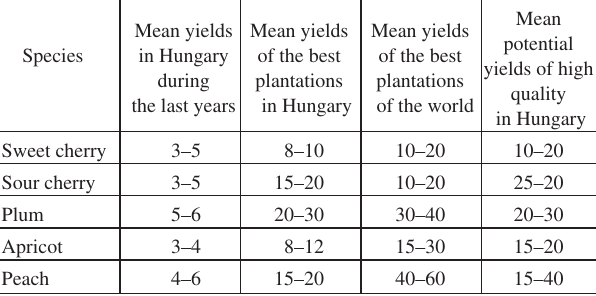
Table 4. Mean yields of stone fruits in Hungary and abroad (t/ha) Mean Mean yields Mean yields Mean yields of the best